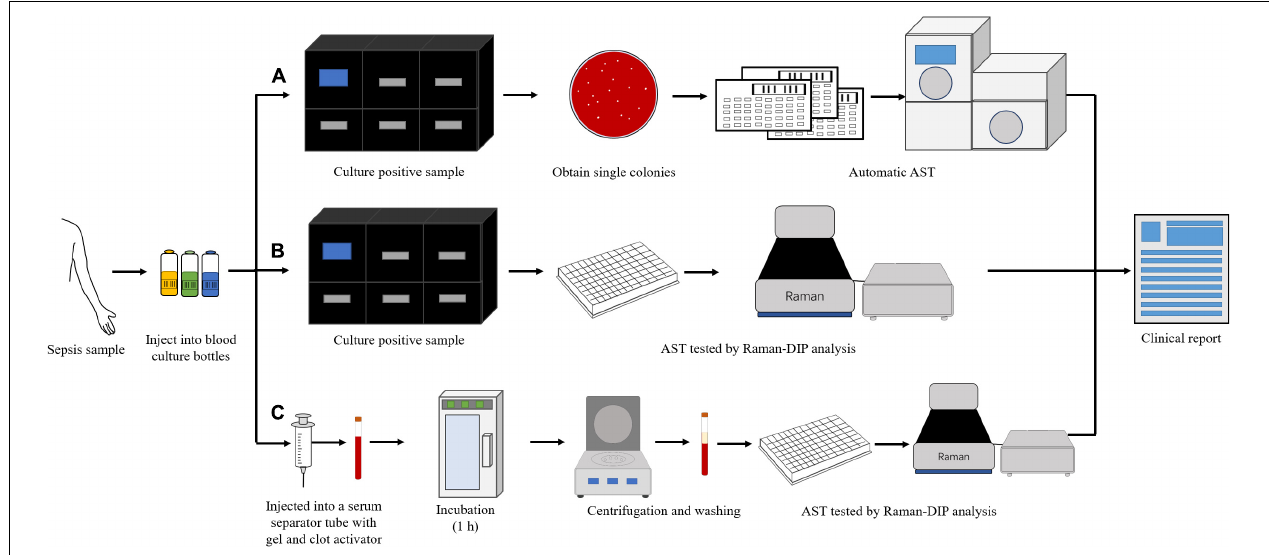
FIGURE 4 | The different procedures of AST for clinical blood samples. (A) the procedure of current clinical routine method; (B) the procedure of current clinical routine method combined with single cell Raman-DIP; and (C) the procedure of this